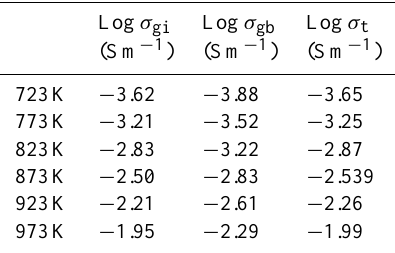
Table 2. The value of grain interior, grain boundary and total electri- cal conductivity under 1.0GPa and 723–973K. The estimate error for grain interior conductivity is lower than 5%, for grain boundary conductivity is lower than 7%, and for total conductivity is lower than